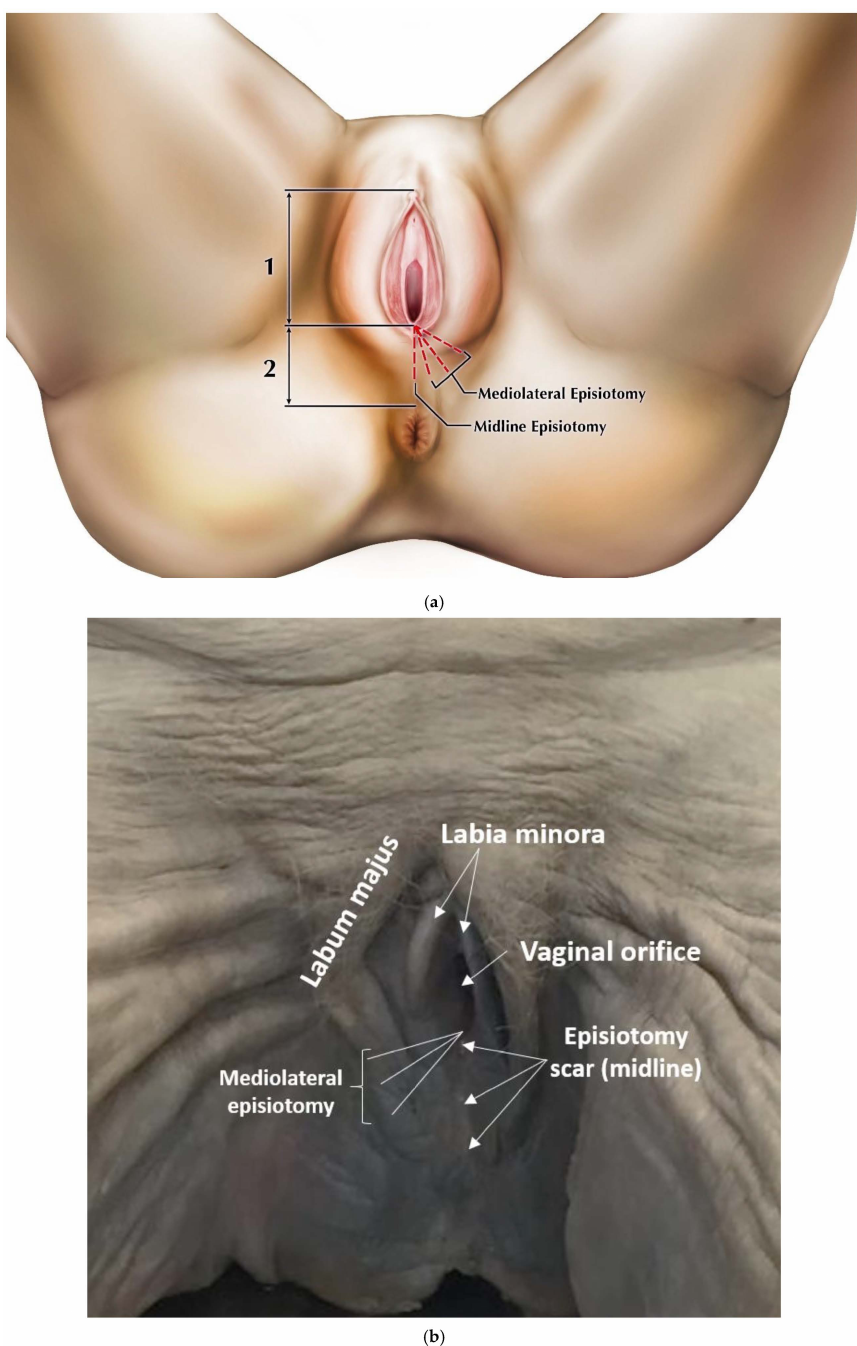
Figure 1. ( a ) . Origins and angles of incisions. Incisions were made in the midline and mediolaterally at high, medium, and low angles. ( b ). Undissected female perineum, with mediolateral episiotomy incisions indicated. This specimen exhibited an already existing episiotomy scar from a midline incision. All incisions originated at the vaginal posterior